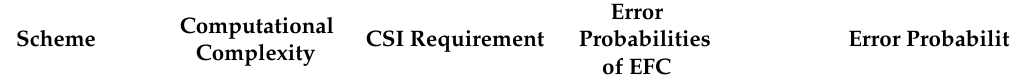
Table 3. Performance comparison of different schemes in the case of perfect